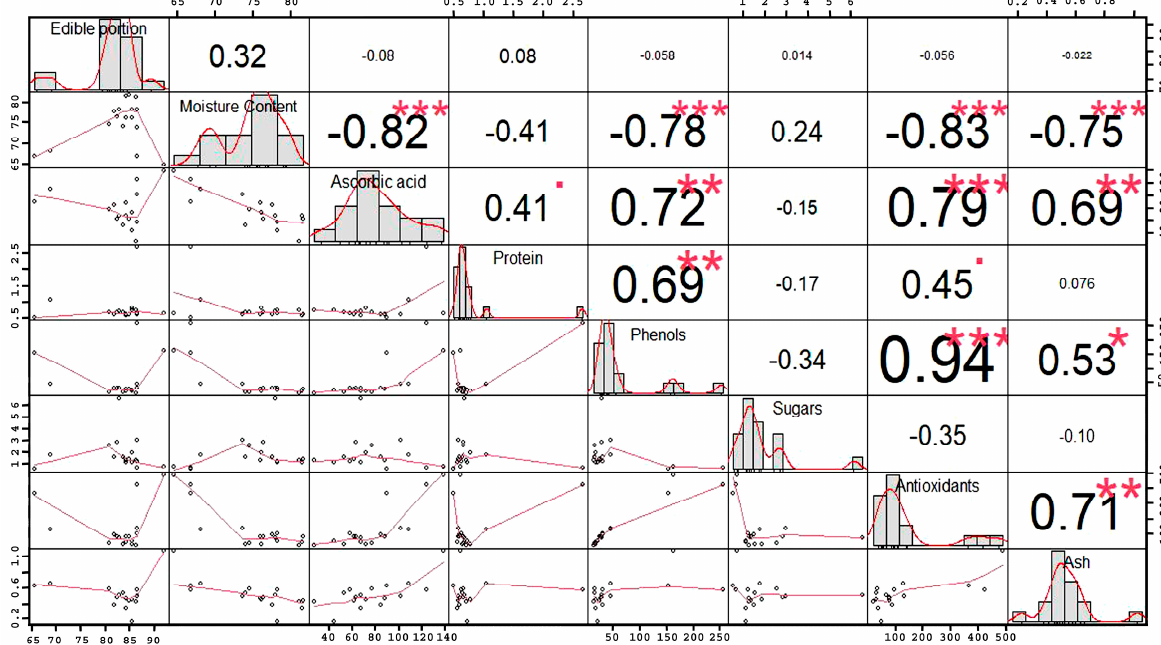
Figure 4. Correlation coefficients among biochemical parameters of jujube fruit quality (Edible portion, Moisture content, Ascorbic acid, Protein, Phenols, Sugars, Antioxidants and Ash) of the 18 genotypes. *, **, *** Significant at p < 0.05; < 0.01; < 0.001, respectively.